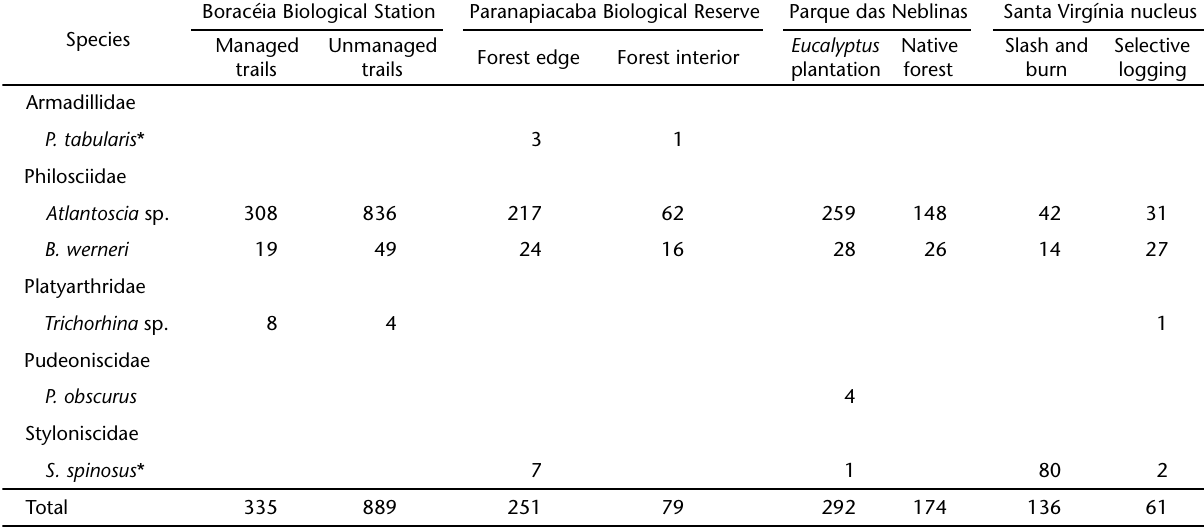
Table II. Abundance of Oniscidea (Isopoda) at four sites of varying disturbance within Atlantic Forest protected areas in the Serra do Mar mountains, state of São Paulo.